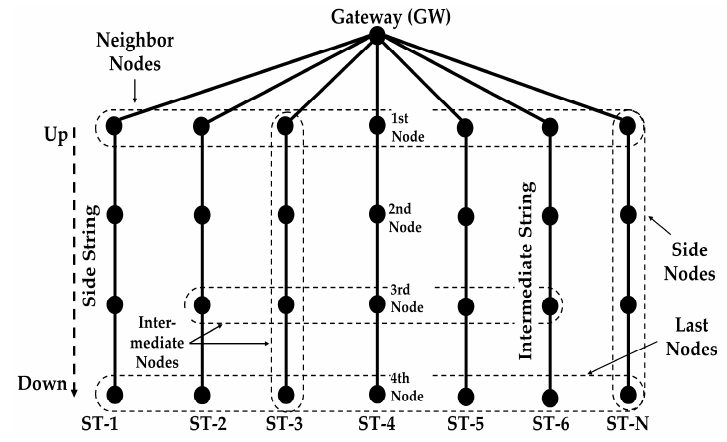
Figure 2. Network Topology of N Strings.